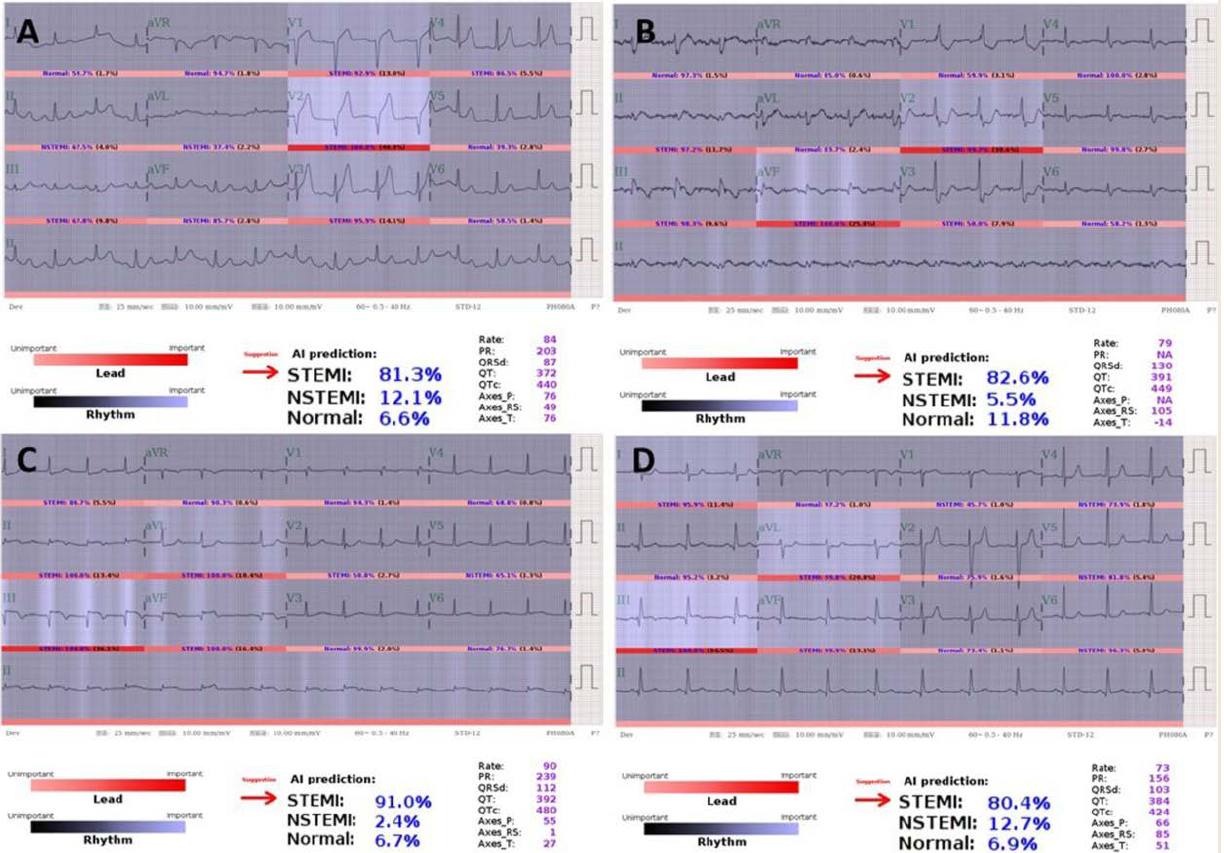
Figure 3. STEMIs for which alarms were raised by the AI-based alarm strategy but for which diagnosis by front-line physicians were delayed. ( A ) A 36-year-old tall man awaiting chest X-ray to rule out pneumothorax. ( B ) An 82-year-old woman presenting with left shoulder pain initially. ( C ) A 75-year-old woman presenting with acute epigastric pain, nausea, and dizziness awaiting an X-ray to rule out a perforated peptic ulcer. ( D ) A 54-year-old man with a chronic kidney disease awaiting labs to rule out